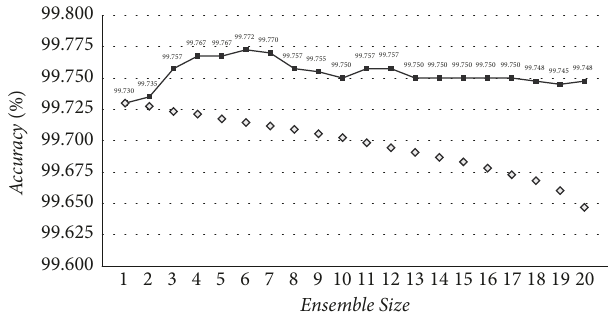
Figure 8: Accuracy of CNNs committees with up to 20 models from GE with EMNIST Digits.